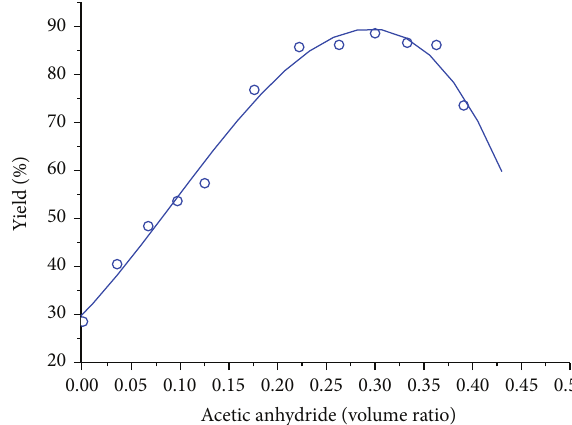
Figure 8: Effect of acetic anhydride proportion on PCHO yield. Reaction conditions: T = 40 ∘ C; reaction time =